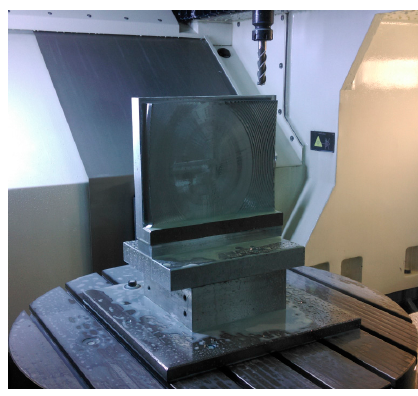
Figure 5. Experimental setup.